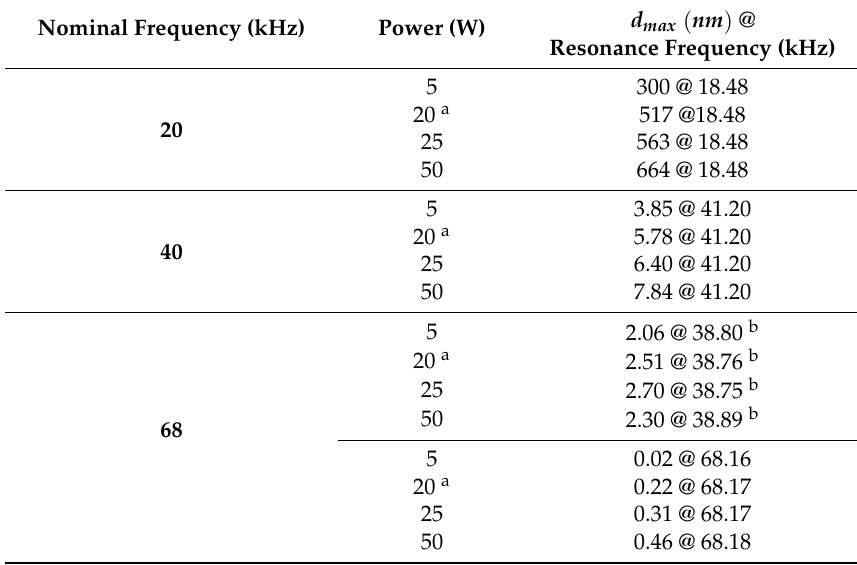
Table 1. Maximum measured displacement (amplitude) d max of all vibration frequencies under different powers (5, 25, and 50 W). We estimated the maximum displacement for 20 W by nonlinear interpolation. Nominal Frequency (kHz) Power (W) d max ( nm ) @ Resonance Frequency